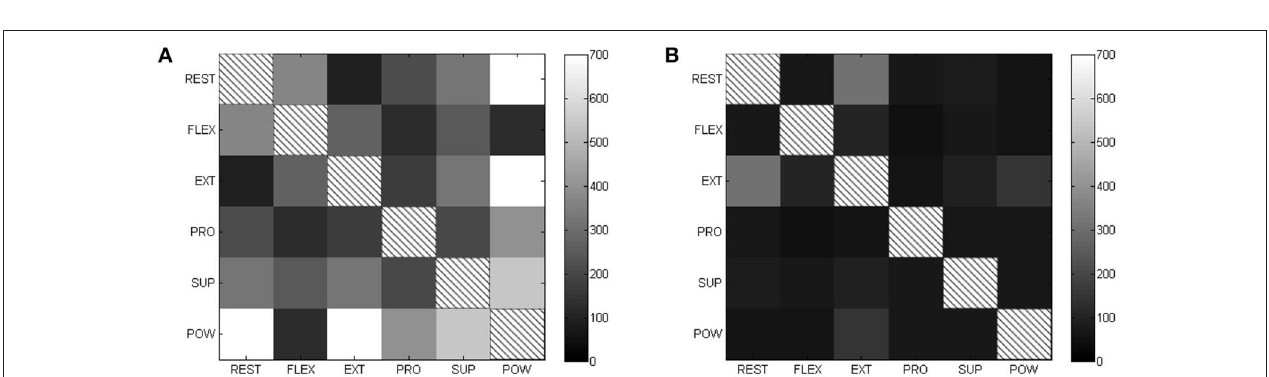
Frontiers in Neurorobotics |